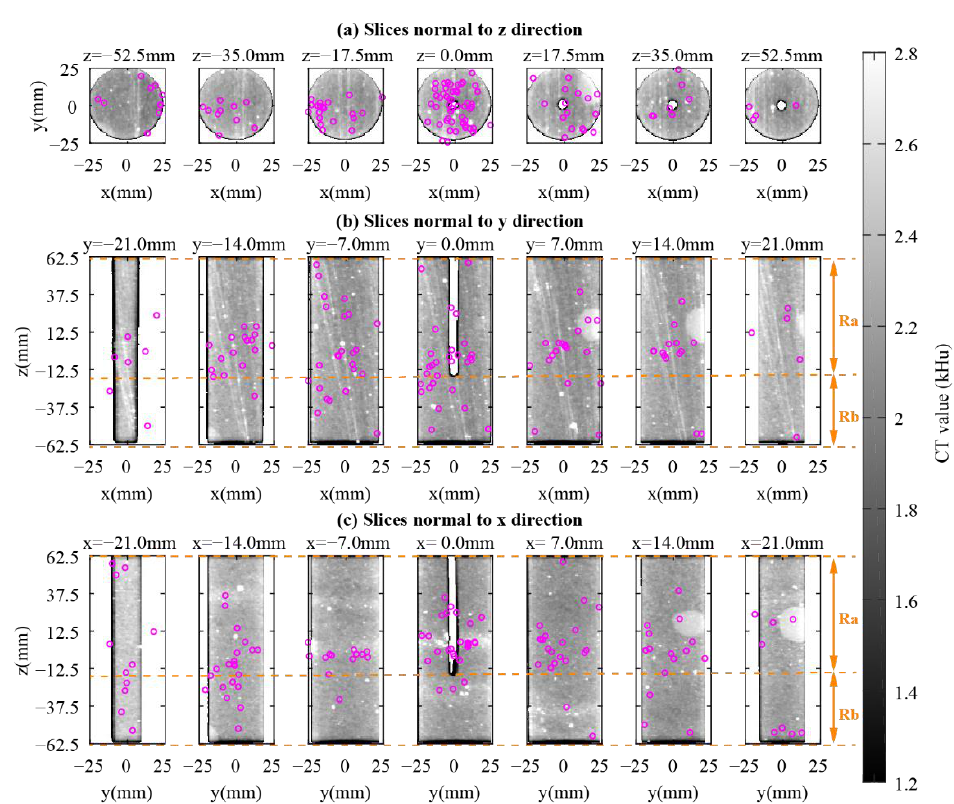
Figure 6. Three-dimensional borehole surface and hydraulic fracture surface extracted from the 3D CT scan images for the ( a ) intact and ( b ) fractured tight sandstone.